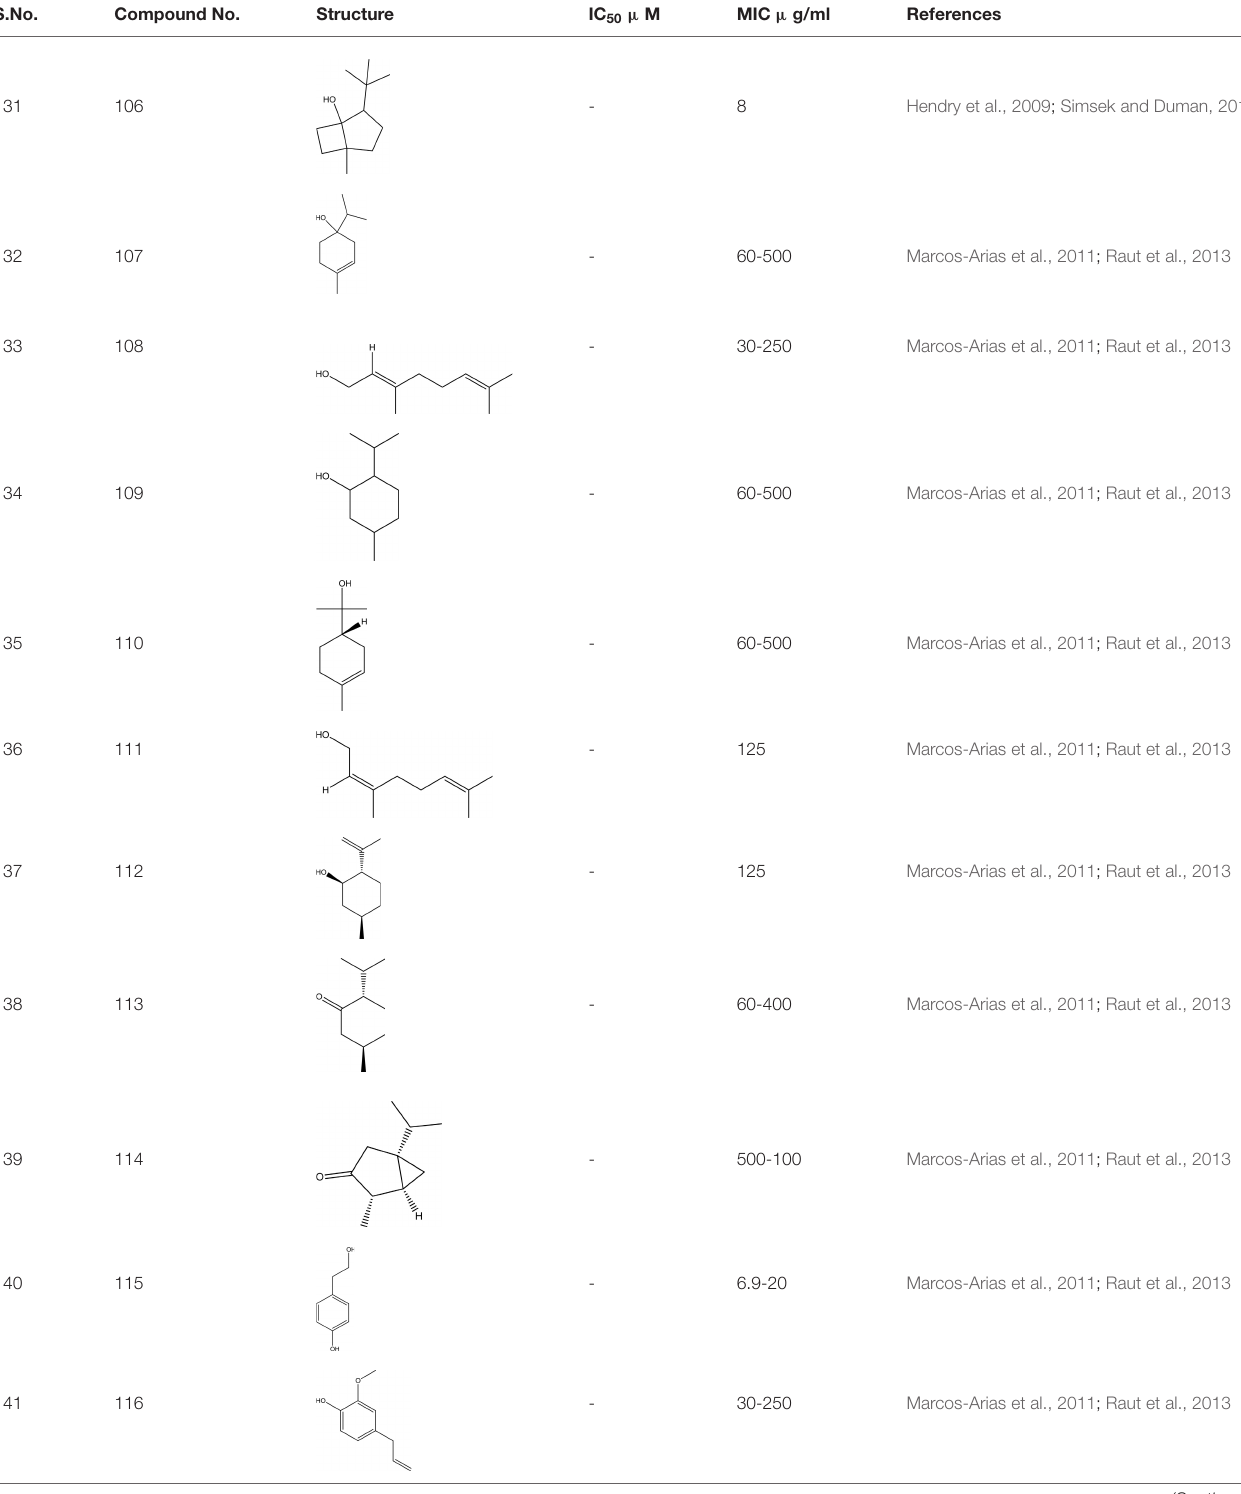
TABLE 8 | Chemical structures and MIC/IC 50 values of small molecule inhibitors (106–122). S.No. Compound